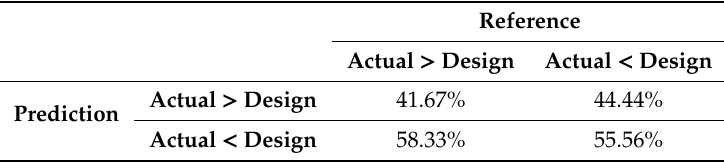
Table A2. Confusion matrix for gradient boosting machine when predicting the reliability of small WWTPs.